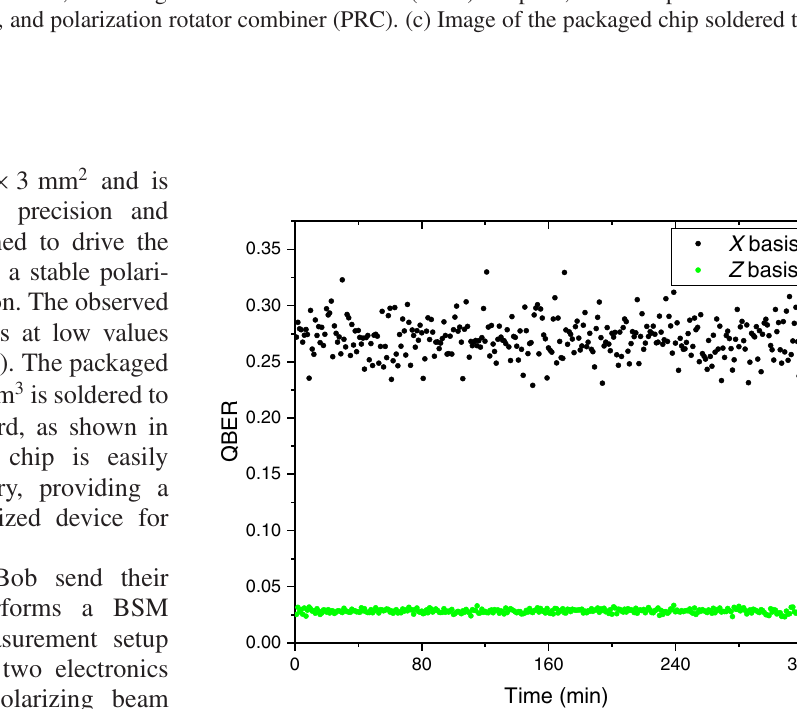
FIG. 3. Observed QBERs in different bases over 36-dB channel loss. The data points are collected without any active adjustment of the system. Each point is calculated by using data collected over a one-minute period. An average QBER of 0 . 028 (cid:2) 0 . 002 ( 0 . 271 (cid:2) 0 . 016 ) in Z ( X ) basis is observed over several hours of